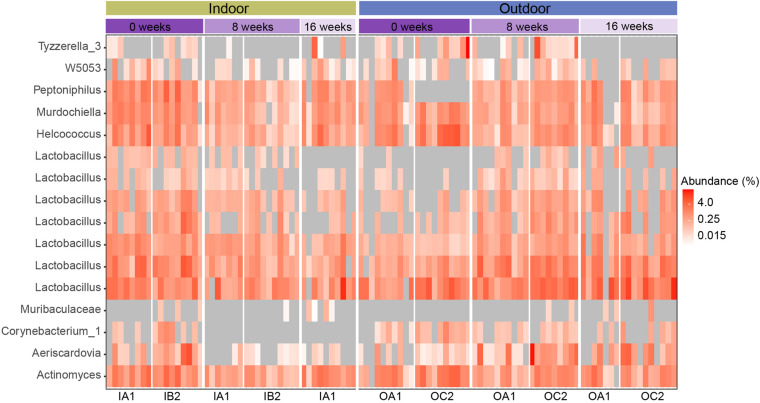
Heatmap of the relative abundance of 16 differentially abundant ASVs that were significantly different over time between indoor and outdoor housed chickens (DESeq2, fdr p < 0.01%). Samples are ordered by poultry house for each sampling time and divided by housing type (indoor vs. outdoor). Each box represents the relative abundance of an ASV in an individual chicken. 0 values are shown as gray boxes.